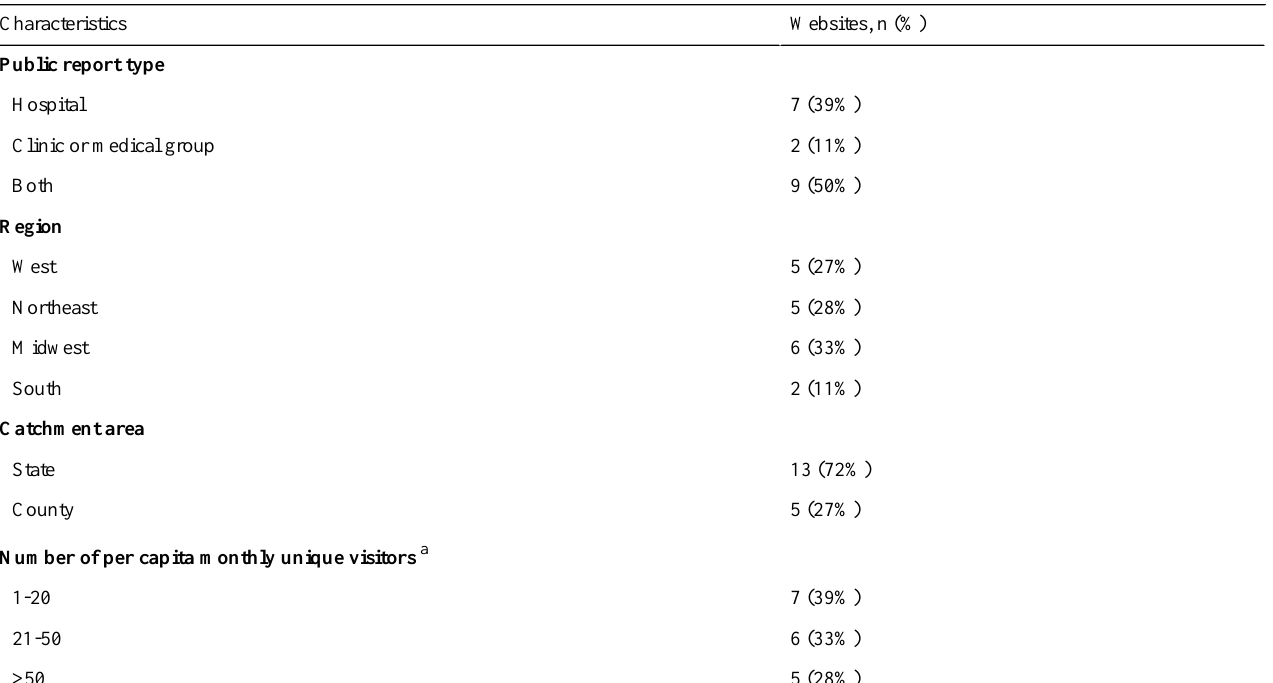
Table 1. Characteristics of participating websites